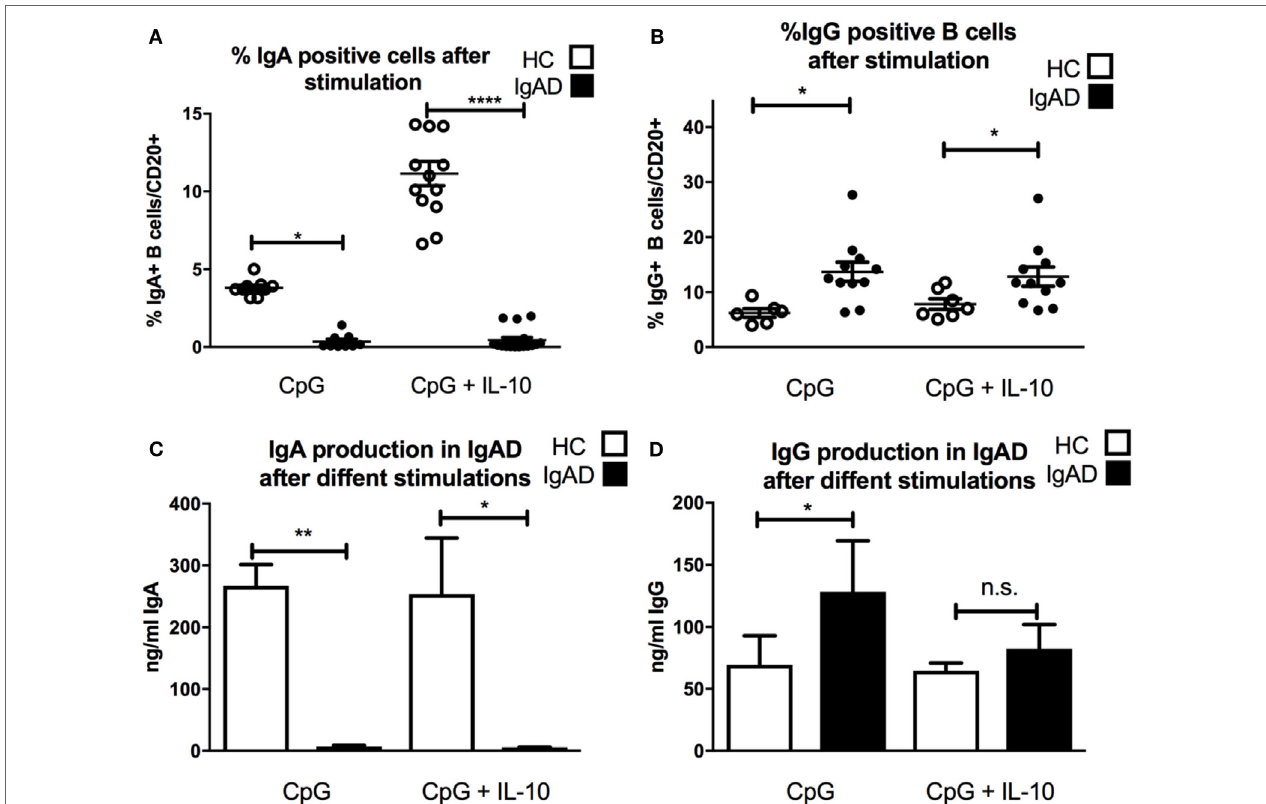
FigUre 3 | The lack of IgA surface expression and production is not corrected by TLR9 stimulation in selective IgA deficiency (IgAD) individuals. The figure shows the responsiveness of isolated CD19 + B cells in IgAD individuals and healthy controls (HC) after 7 days of CpG or CpG with IL-10 stimulation as evaluated by IgA and IgG expression and secretion evaluated by flow cytometry and enzyme-linked immunosorbent assay. IgAD donor B cells express a lower proportion of IgA (a) and high of IgG (B) following CpG stimulation. This unresponsiveness is not overcome by the addition of IL-10 (a,B) . In HC, an increase is seen in the proportion of IgA but not IgG positive B cells when IL-10 is added to the CpG stimulation (a,B) . IgA production (c) is seen following CpG stimulation in HC but not in IgAD individuals. Defective IgA secretion is not rescued in CpG stimulated IgAD B cells by the addition of IL-10. On the contrary, IgG production is significantly higher in IgAD individuals compared to HC after CpG stimulation (D) . This difference is less distinct after the addition of IL-10 and is not statistically significant. In all figures, HC are depicted as white, while IgAD individuals are depicted as black bars. Data are shown as mean ± SEM of all IgAD and HC assessed. All data are from five-independent experiments, no duplicates. Significance is shown as * p < 0.05, ** p < 0.01, *** p < 0.001 (as determined by one-way